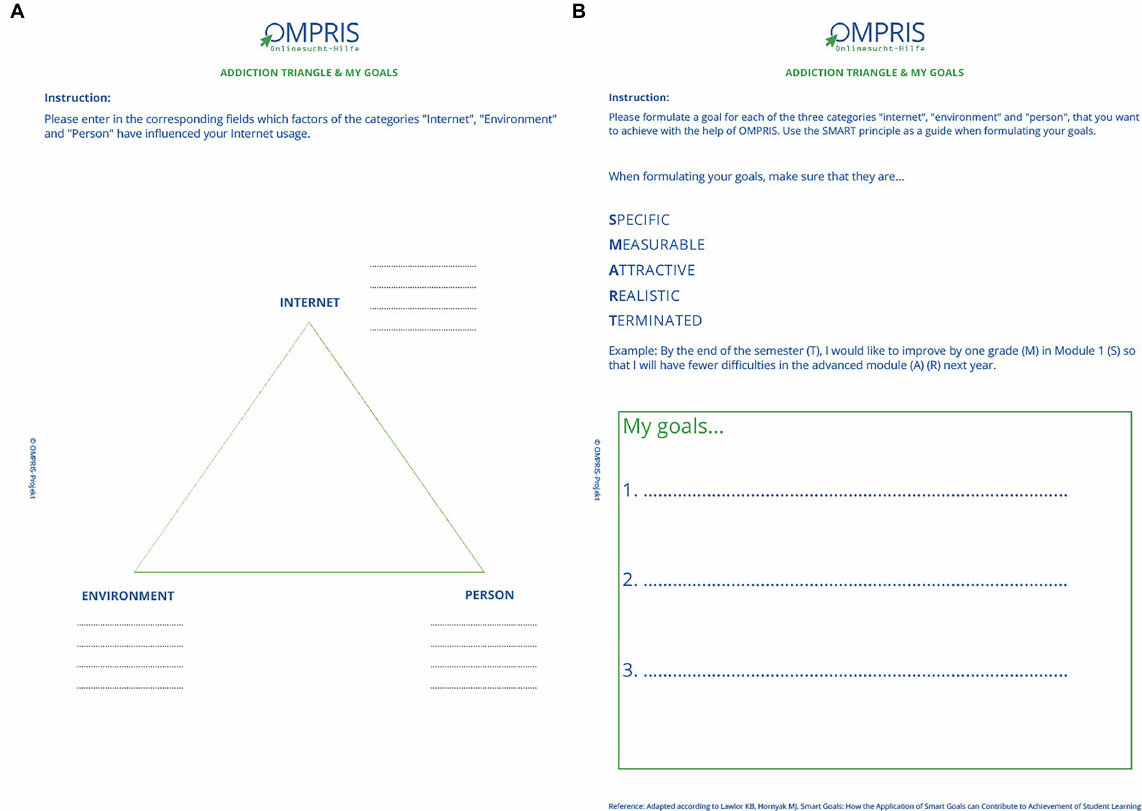
FIGURE 1 (A, B) Addiction triangle and